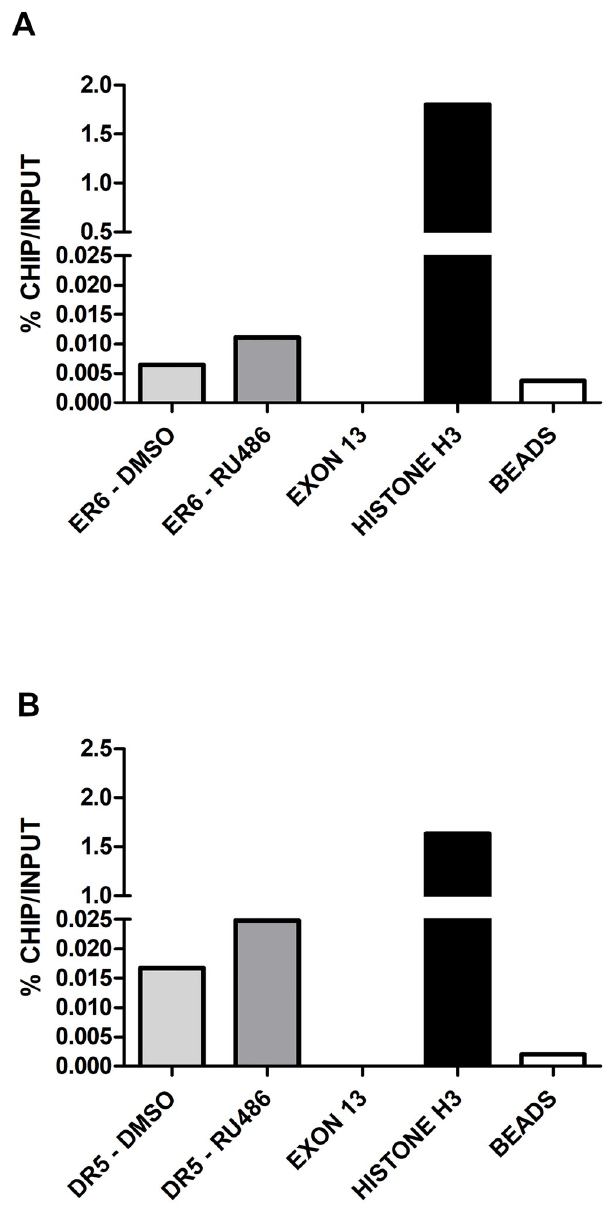
Fig 8. ChIP in control and treated BFH12 cells to quantify the binding of RXR α to ER6 and DR5 binding sites. BFH12 cells were exposed to 0.1% DMSO and 100 μ M RU486 for 6 hours. Chromatin was isolated, subjected to ChIP using anti-human RXR α antibody and quantified by qPCR as described in S1 File. Results for ER6 and DR5 DNA regions are reported in panels A and B, respectively. Data are normalized to input DNA and expressed as % ChIP/ input. The experiment was performed four times independently, and similar results were obtained. The data shown derived from a representative experiment. Chromatin samples from control cells immunoprecipitated with or without Histone H3 antibody are shown as Histone H3 and beads, respectively. A further negative control (exon 13), representing a CYP3A28 DNA region without NR binding sites, is reported in the graph. In all experiments, negative and positive controls behaved as